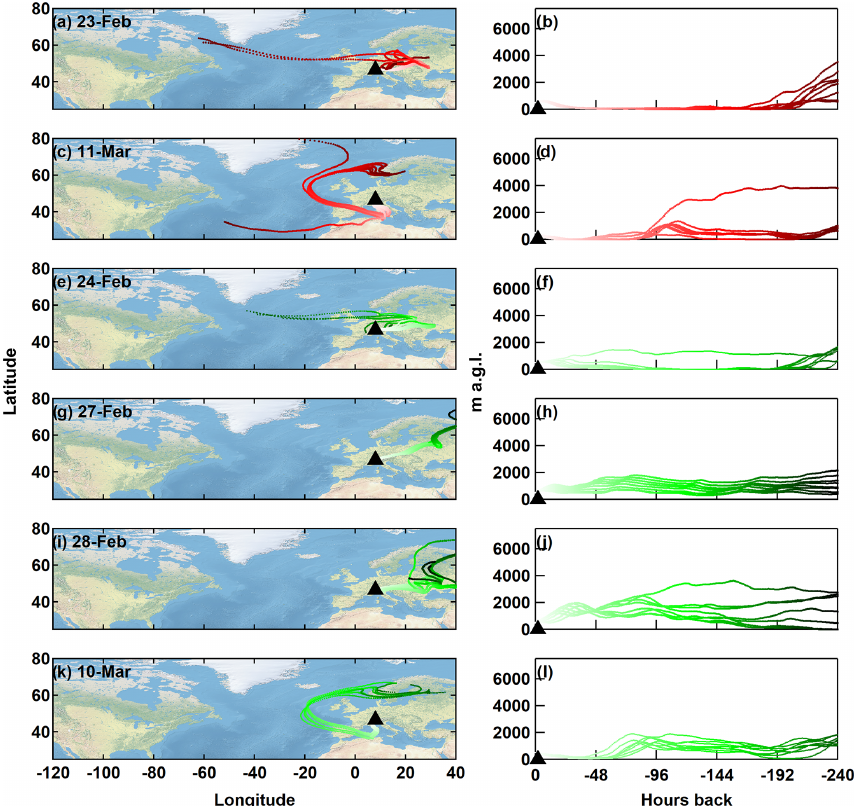
Figure 4. Same as Fig. 3 but for southeasterly (23 February and 11 March), SDE (24 February and 10 March), and BLI (27 and 28 February) case